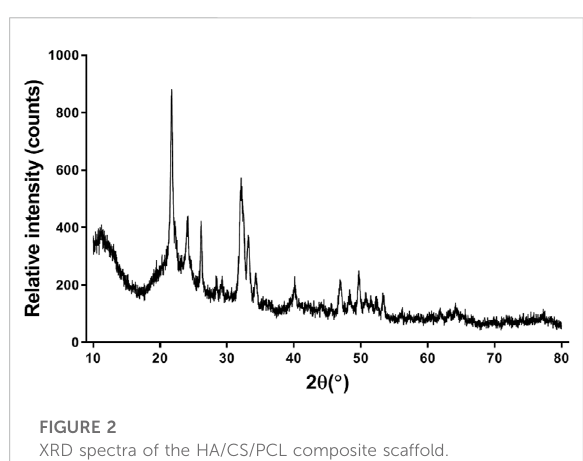
FIGURE 2 XRD spectra of the HA/CS/PCL composite